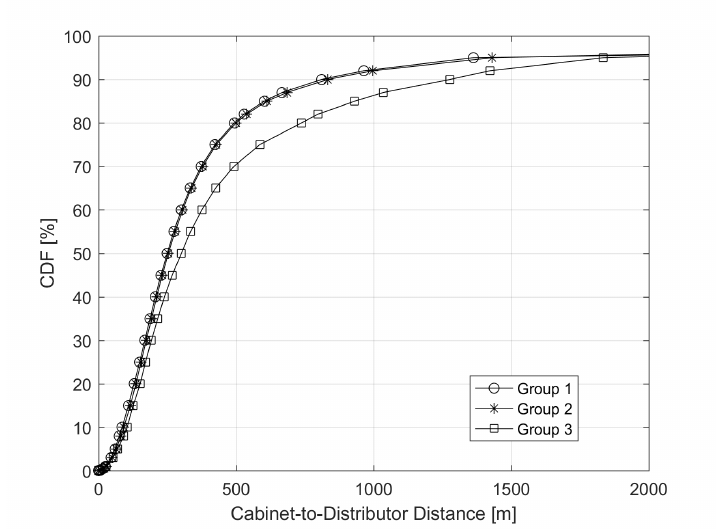
Figure 3. CDF of the distances of the distributors from the Cabinet in the case of FttC for Italy.